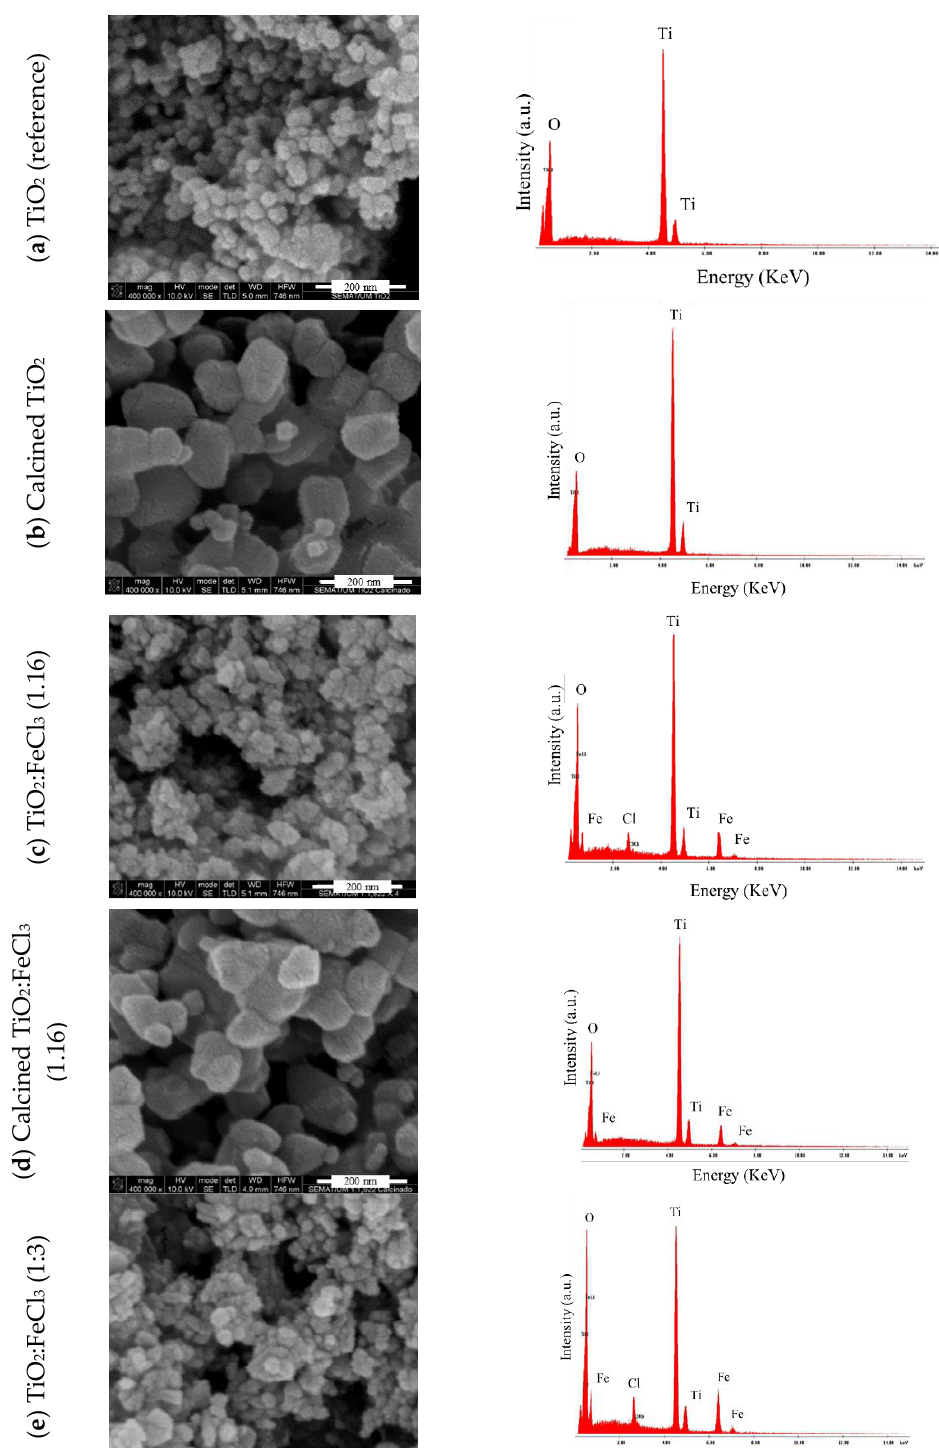
Figure 3. SEM micrograph representation ( left ) and EDS spectrum ( right ) of: ( a ) reference TiO 2 , ( b ) calcined TiO 2, ( c ) TiO 2 -FeCl 3 (1:1.6), ( d ) calcined TiO 2 -FeCl 3 (1:1.6) and ( e ) TiO 2 -FeCl 3 (1:3).